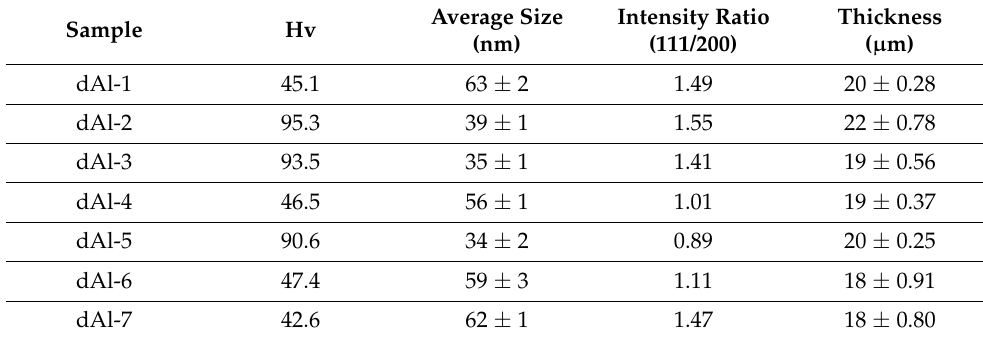
Table 3. Vickers hardness, plating thickness, and XRD analysis results.